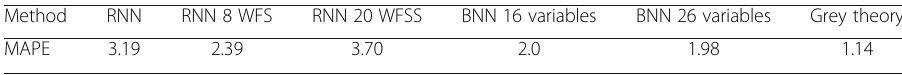
Table 10 A comparison between different methods for predicting Bitcoin